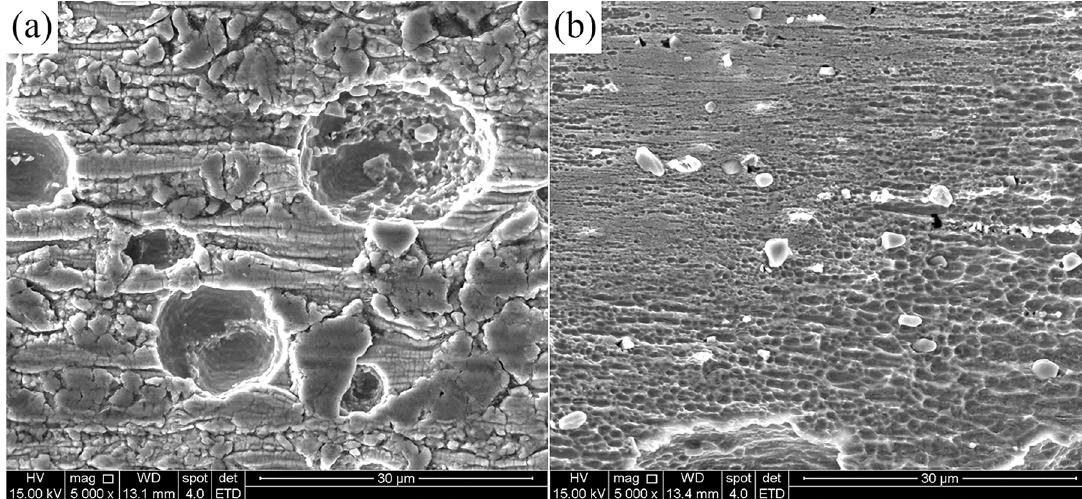
Figure 8. Surface morphologies of superelastic NiTi wires after potentiodynamic polarization in Hank's solution: (a) as received and (b) polished.